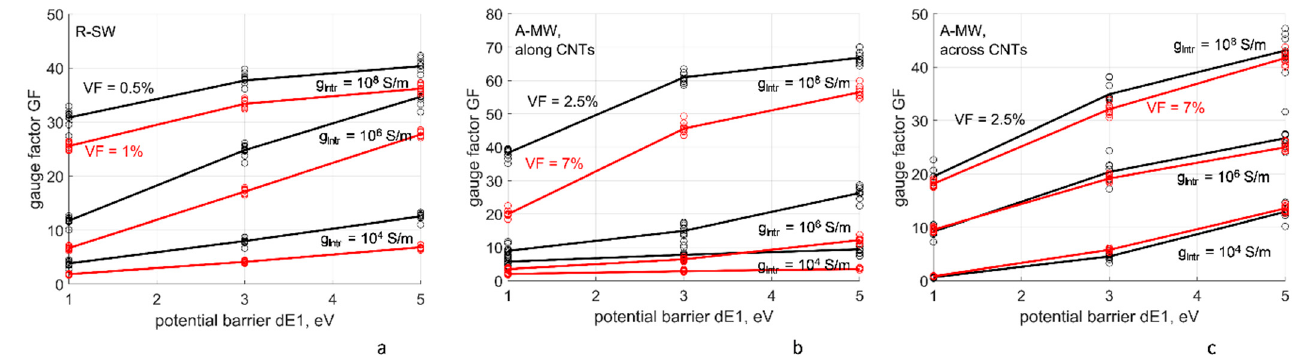
Figure 11. The gauge factors as functions of the assumed potential barrier Δ E 1 for the tunneling conductivity, s min = 0.34 nm, at three levels of the CNT intrinsic conductivity g intr and two levels of the CNT volume fraction: ( a ) R-SW; ( b , c ) A-MW: along CNTs ( b ) and across CNTs ( c ). The points show conductivity values, corresponding to different RVE random realizations; the lines show mean values.